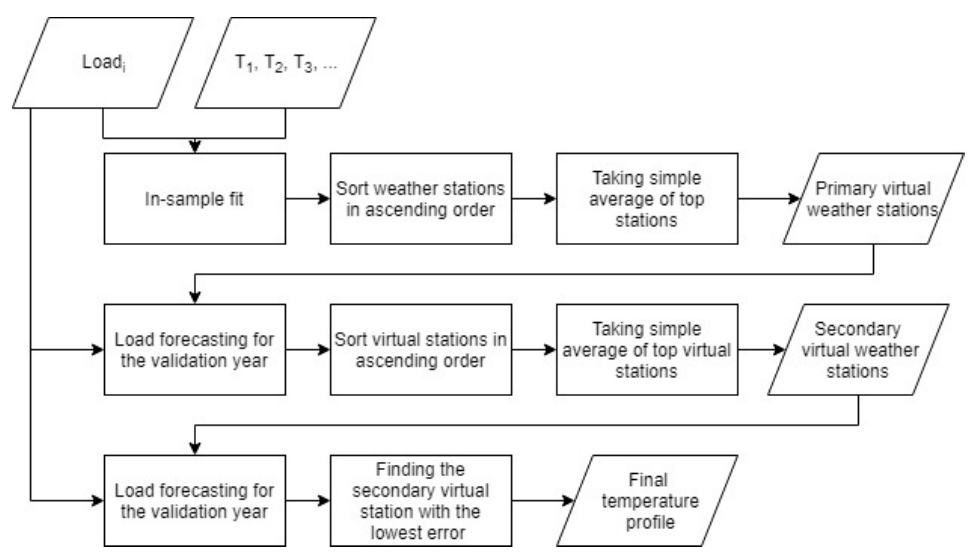
Figure 1. Twofold combination flowchart.